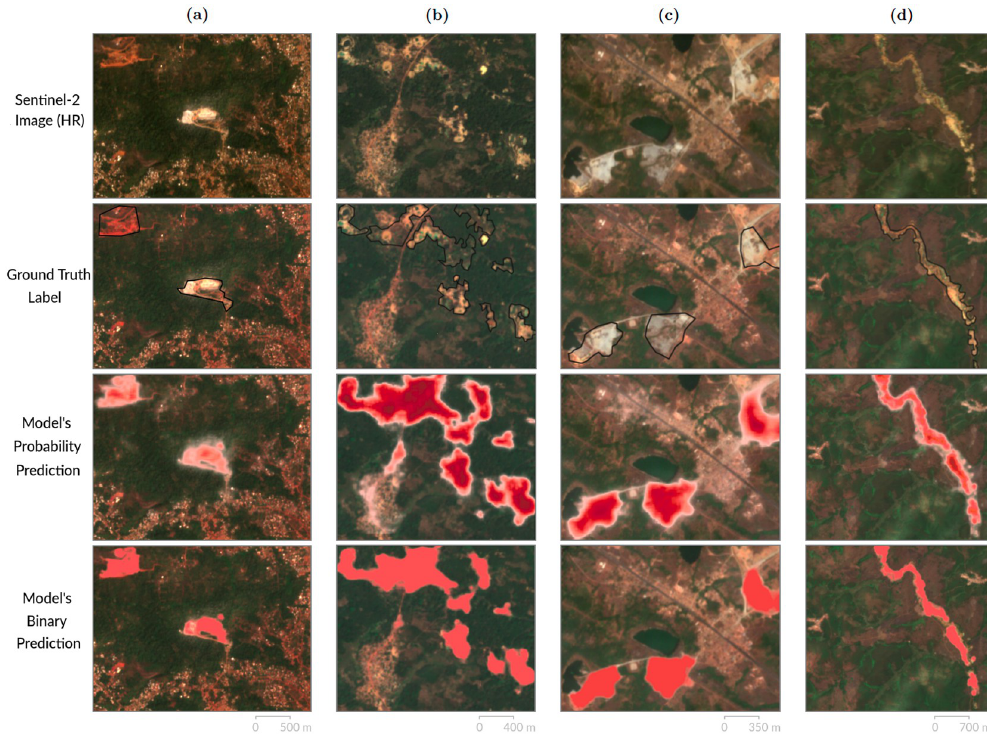
Fig 4. Timeline examples of various regions predicted by the model. Four examples of predictions performed by our model, from various parts of the studied region. Each vertical timeline chronologically presents i) a sample of Sentinel-2 (S2) model’s input image as reference, ii) the ground truth ASM contouring label (in black) for this S2 sample, iii) the corresponding probability prediction performed by our model, and iv) the binary prediction obtained after applying a probability threshold T = 0.5. Sample a) comes from Yaounde´ city in Cameroon (3˚58’N: 11˚30’E), sample b) comes from Kenema District in Sierra Leone (8˚10’N: 10˚56’W), sample c) comes from southern Nigeria (6˚44’N: 5˚09’E) and sample d) comes from Koinadugu District, Sierra Leone (9˚09’N: 11˚27’W). Sources: Sentinel-2 (from the Copernicus program) & author calculations